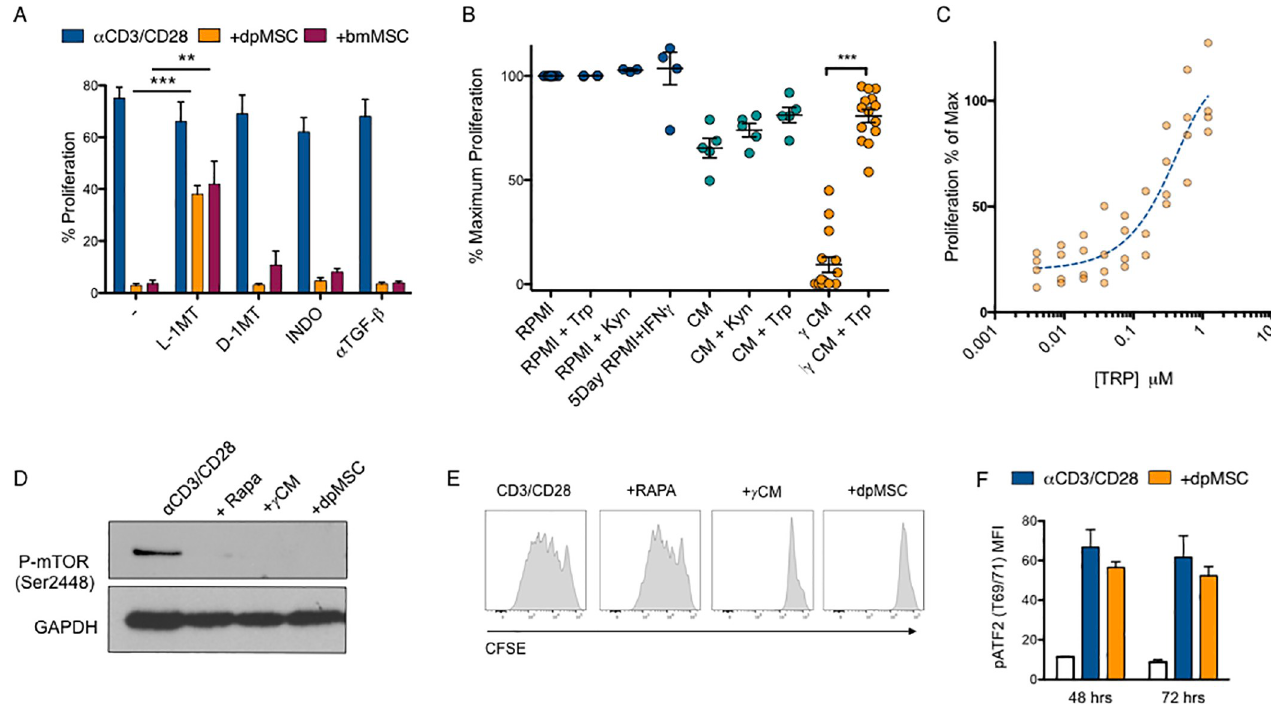
Fig 1. Tryptophan starvation inhibits T-cell proliferation through activation of GCN2 and induction of ER-stress. (A) Proliferation of α CD3/ CD28-activated CFSE labelled PBMC co-cultured with either bmMSC or dpMSC in the presence of L-1-MT, D-1-MT, indomethacin, or TGF- β neutralizing antibody (n = 6). ( B) Proliferation of α CD3/CD28-activated CFSE labelled CD4 + T-cells cultured in 100% non-activated dpMSC conditioned medium (CM) or IFN- γ activated dpMSC conditioned medium ( γ CM), supplemented with Kynurenine (Kyn) or Tryptophan (Trp) (n = < 13). ( C ) α CD3/CD28-activated CD4 + T-cells cultured in 100% γ CM supplemented with increasing concentrations of Tryptophan (Trp). Proliferation was determined by CFSE dilution (n = 4). ( D ) Representative immunoblot of phopsho-mTOR (pmTOR) in α CD3/CD28-activated CD4 + T-cells (72 hours) cultured with Rapamycin (Rapa), Tryptophan (Trp) free conditions or in the presence of dpMSC. ( E) Representative histograms showing CFSE proliferation of α CD3/CD28-activated CD4 + T-cells (72 hours) cultured with Rapamycin, conditioned medium γ CM or with dpMSC. Data are pooled from at least two independent experiments. (F) Flow cytometry analysis of phospho-ATF2 (MFI) in α CD3/CD28-activated CD4 + T cells cultured for 48 and 72 hours in the presence or not of dpMSC. (White) = non- activated T cells; (Blue) = α CD3/CD28; (Orange) = dpMSC.